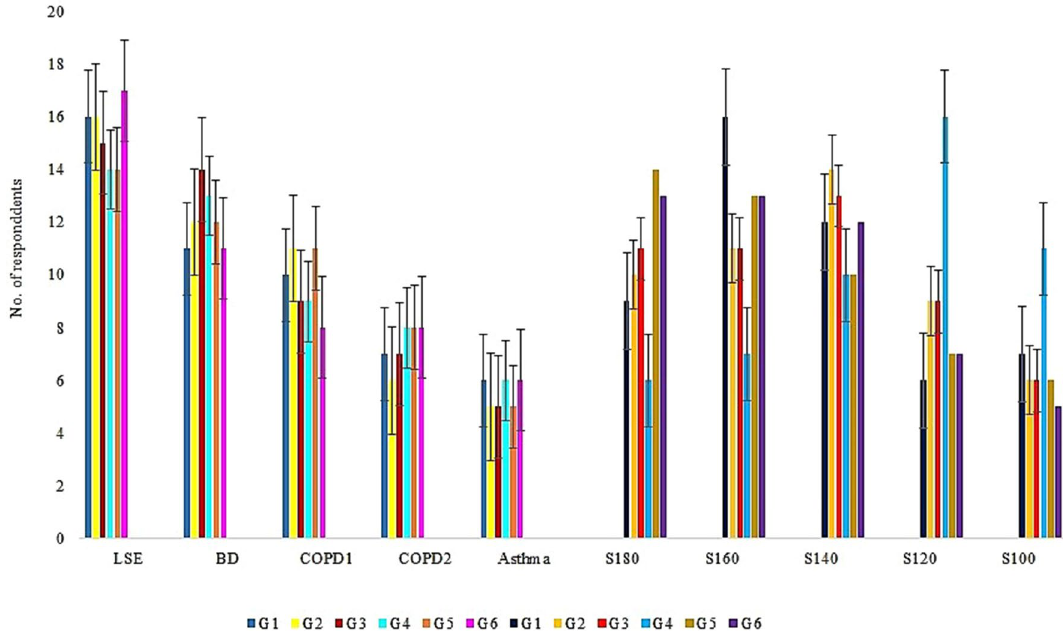
Figure 4. Number of respondents Vs respiratory ailments & room size. LSE low symptomatic effect; BD breathing difficulty, COPD1 chronic obstructive pulmonary disease (cough); COPD2 chronic obstructive pulmonary disease-(Emphysema), S100–S180: area of room in